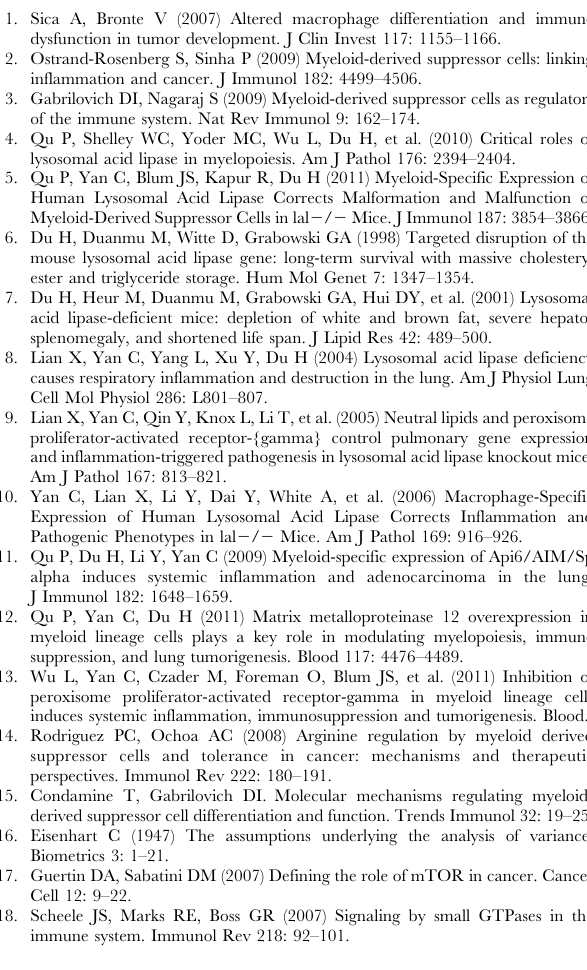
Table S2 Up-regulation of metabolic enzyme genes in the pentose pathway in MDSCs from the bone marrow of lal 2 / 2 mice. Table S3 Up-regulation of mitochondrial ribosomal protein subunits in lal 2 / 2 bone marrow MDSCs. Table S4 Changes of vesicle traffic motor genes in MDSCs from the bone marrow of lal 2 / 2 mice. Table S5 Changes of vesicle traffic tethering factor and membrane fusion factor genes in MDSCs from the bone marrow of lal 2 / 2